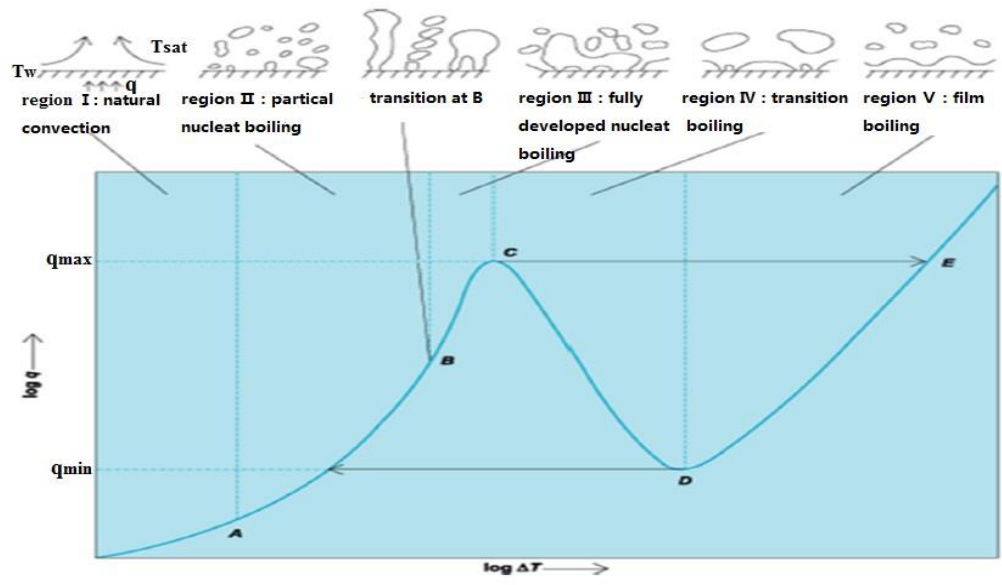
Figure 1. Boiling curve [20].